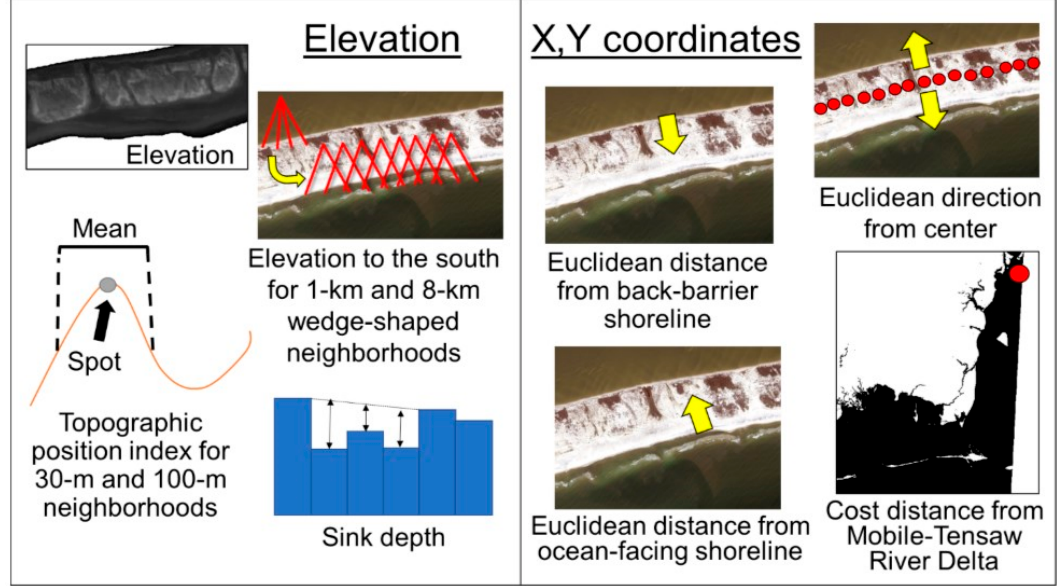
Figure 4. Landscape position predictor variables for the barrier island habitat modeling effort on Dauphin Island, Alabama, USA. The imagery source data is 0.3 m color-infrared orthophotography acquired in December 2015, and the elevation data source data is a 1 m digital elevation model from January 2015. Both of these data were collected by Digital Aerial Solutions, LLC (Riverview, Florida, USA) and the U.S. Geological Survey.